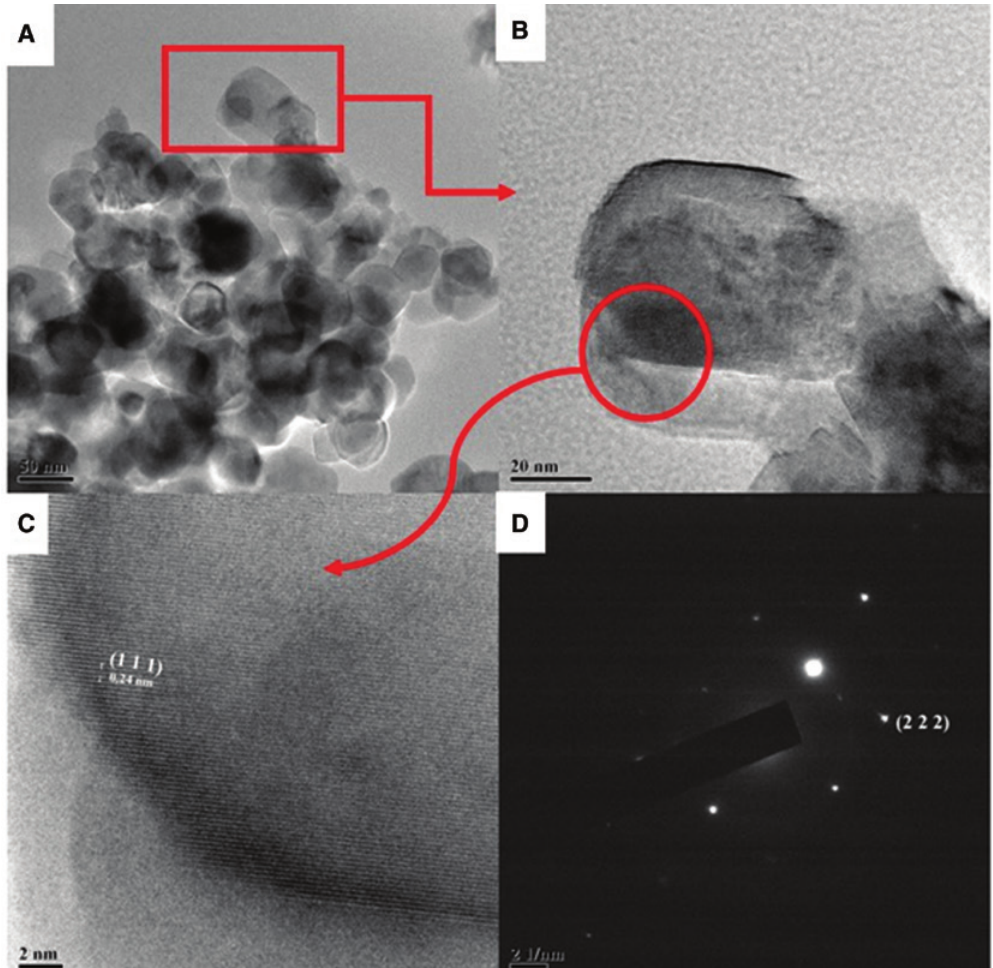
Figure 8: Transmission electron microscopy (TEM) image of of Zn 2 + doped MgO nanoparticles: (A) and (B) with different magnifications, (C) high-resolution transmission electron microscopy (HRTEM) image, (D) selected area of electron diffraction (SAED)